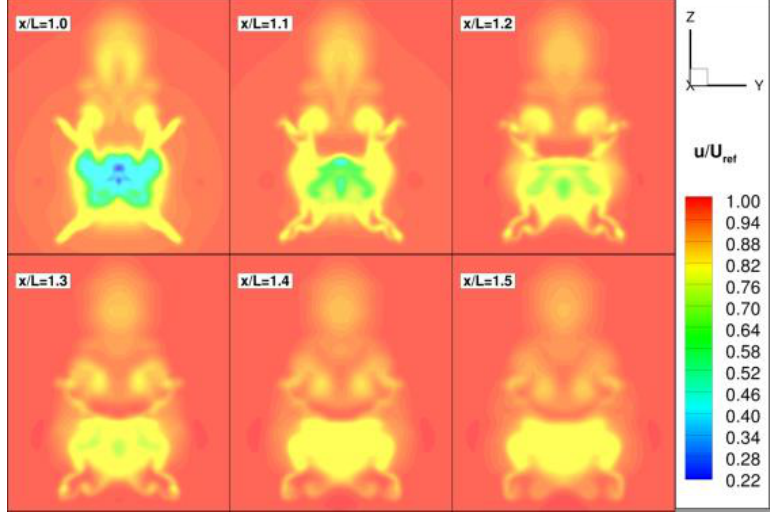
Figure 12. Averaged non-dimensional axial velocity on six downstream